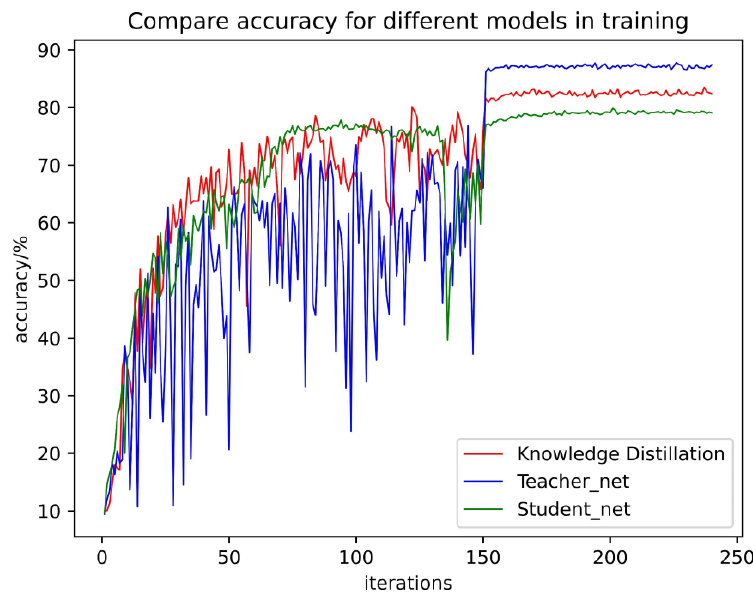
Figure 10. Ablation experiment curve.